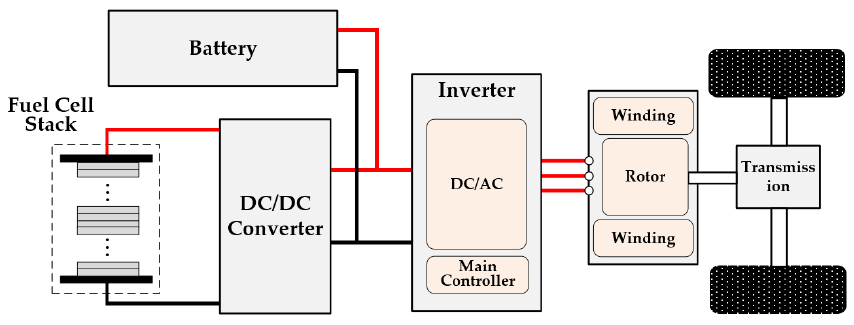
Figure 1. Schematic of HFR measurement based on the dc-dc converter in the conventional drive system.